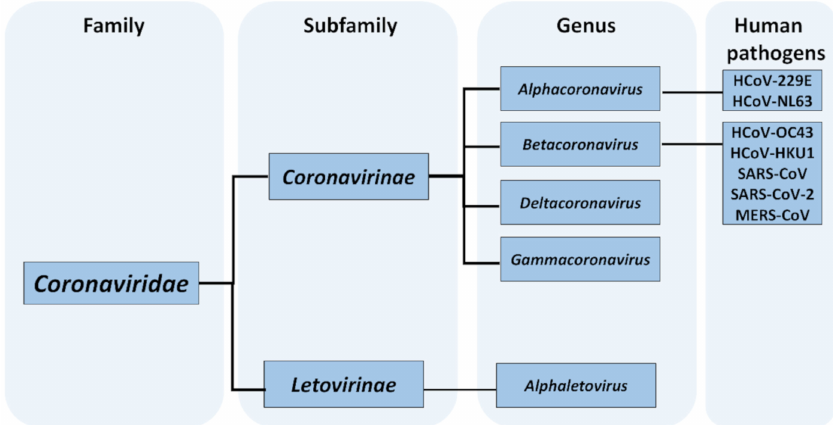
Figure 1. Taxonomy of Coronaviridae family with an indication of species known to be pathogenic to humans and cause respiratory diseases